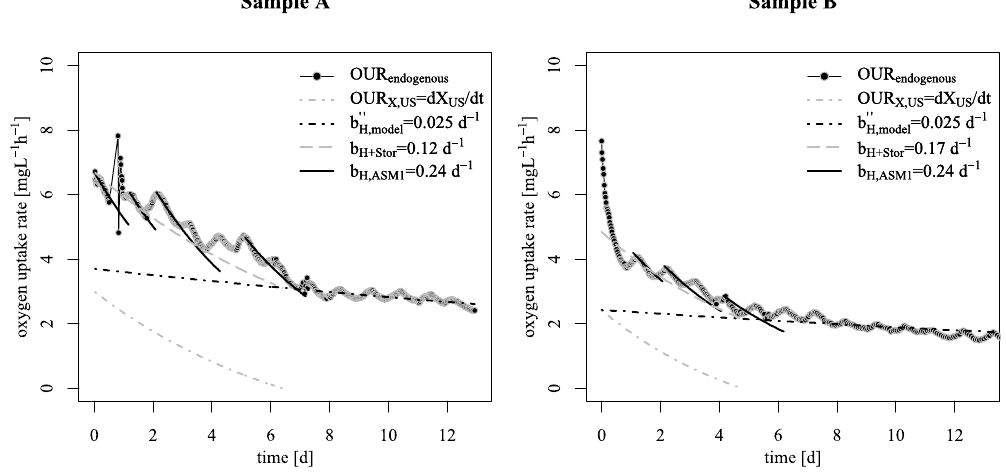
Figure 7. Alternation of decay rate during starvation of biofilm carrier.